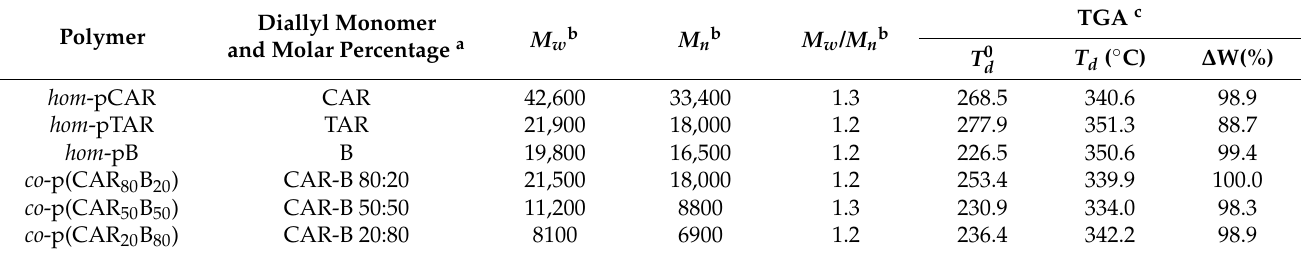
Table 2. GPC and TGA data for synthesized homopolymers and copolymers.